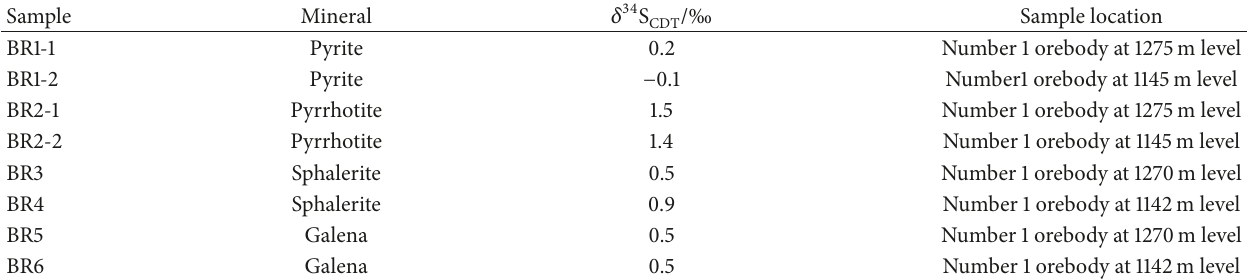
Table 3: Sulfur isotope data for ore minerals of the Bairendaba Ag-Zn-Pb